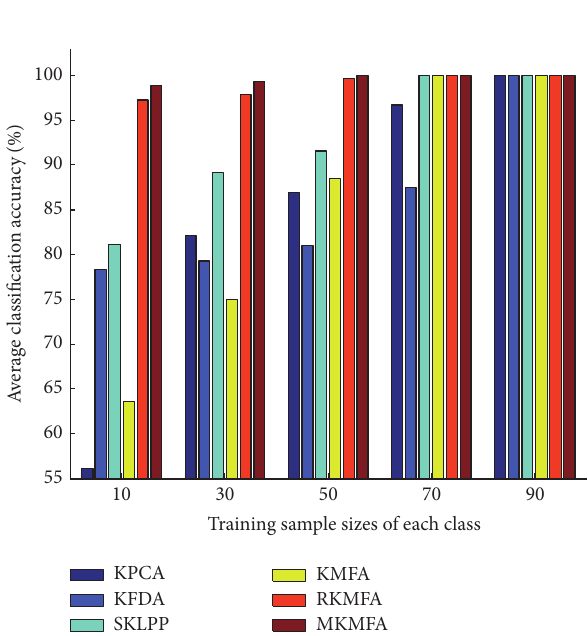
Figure 10: The comparison of the average accuracies for various training sample